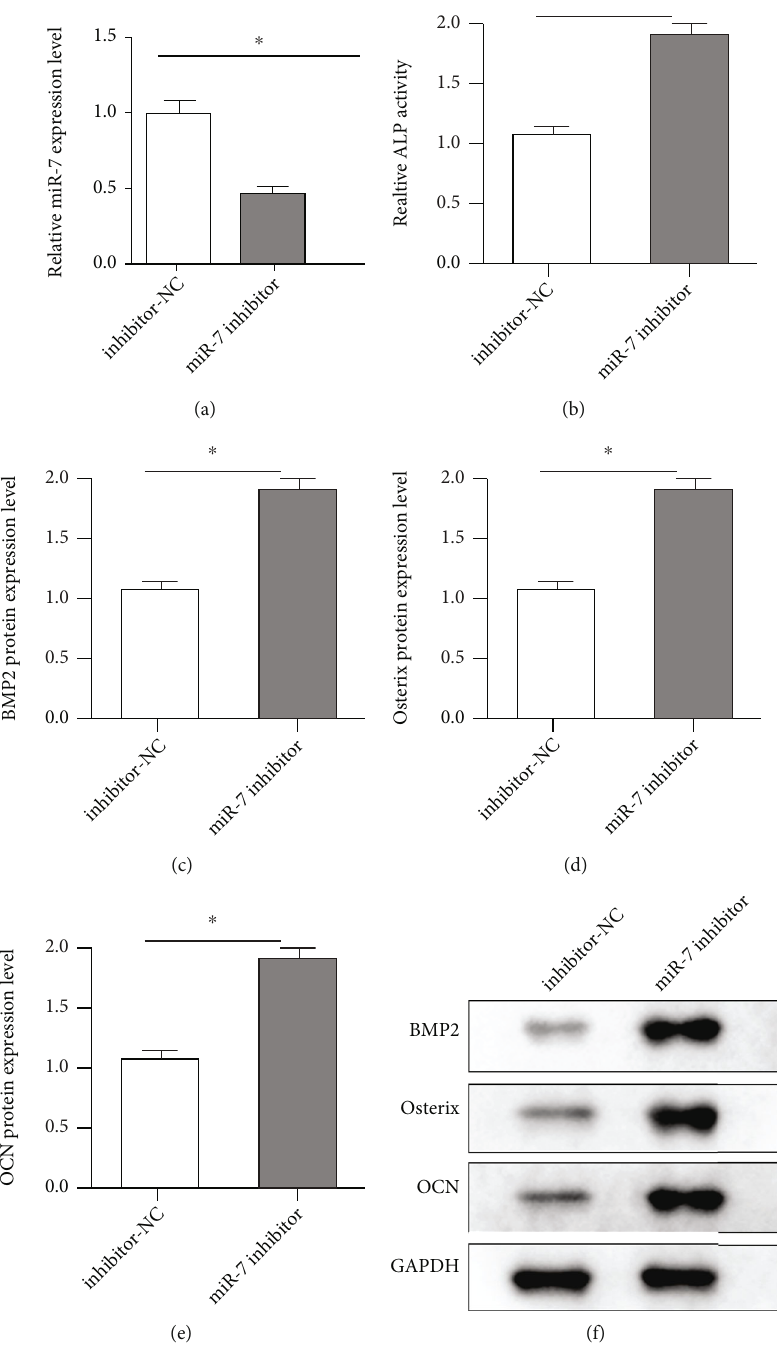
Figure 6: miR-7 downregulation facilitated PDLC osteogenic di ff erentiation. (a) The transfection e ffi ciency was measured by qPCR in PDLC transfection of miR-7 inhibitor and inhibitor-NC. (b) After transfection, ALP activity was evaluated. The protein levels of (c) BMP2, (d) Osterix, and (e) OCN were quanti fi ed. (f) The proteins were assessed by Western blot. ∗ P < 0 : 05 ; ∗∗ P < 0 : 01